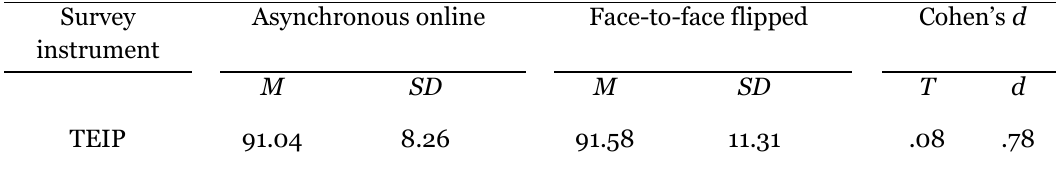
Mean Differences in Efficacy for Preservice Teachers on TEIP Depending on Delivery Format